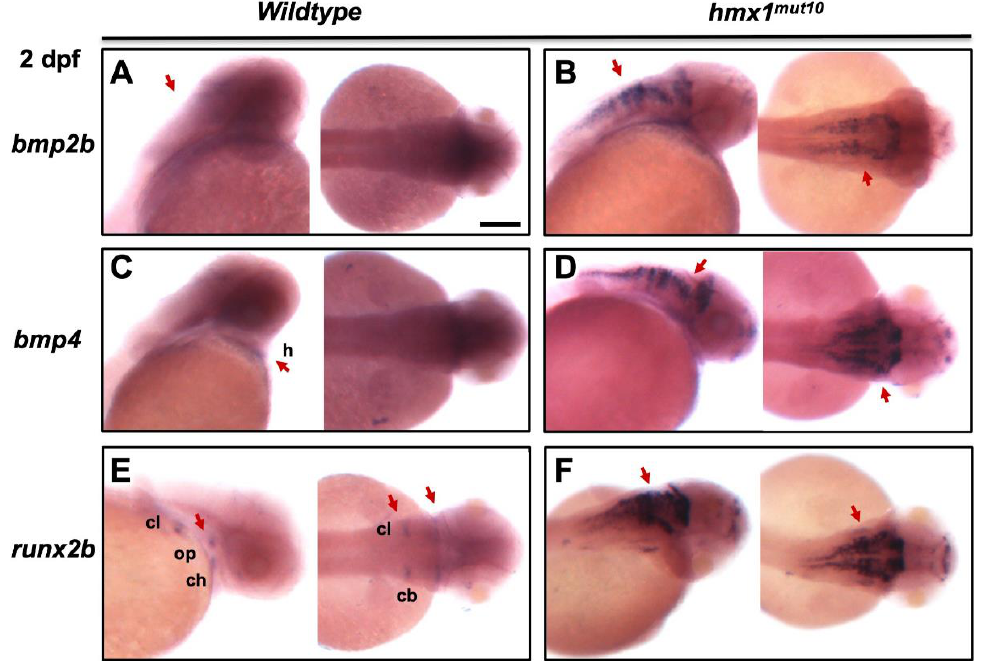
Figure 4. In situ hybridization detected bmp2b and bmp4 the dorsal region in Hmx1 mut10 embryos: In situ hybridization in wildtype and hmx1 mut10 embryos at 2 dpf. Staining for bmp2b , bmp4 , and runx2b. No signal was detected for bmp2b and bmp4 in the dorsal region of wildtype zebrafish, while bmp4 was detected in the heart region (( A , C ) red arrows). In hmx1 mut10 , bmp2b and bmp4 are expressed in the dorsal region ( B , D ). Runx2b in wildtype embryos at 2 dpf is expressed in the bone-forming regions ( E ). In hmx1 mut10 embryos, runx2b is expressed in the dorsal region, and presents a similar pattern to bmp2b and bmp4 ( F ). Cl, cleithrum; ch, ceratohyal; cb, ceratobranchial; h, heart; op, opercle. Bar, A – F 100 μ m.